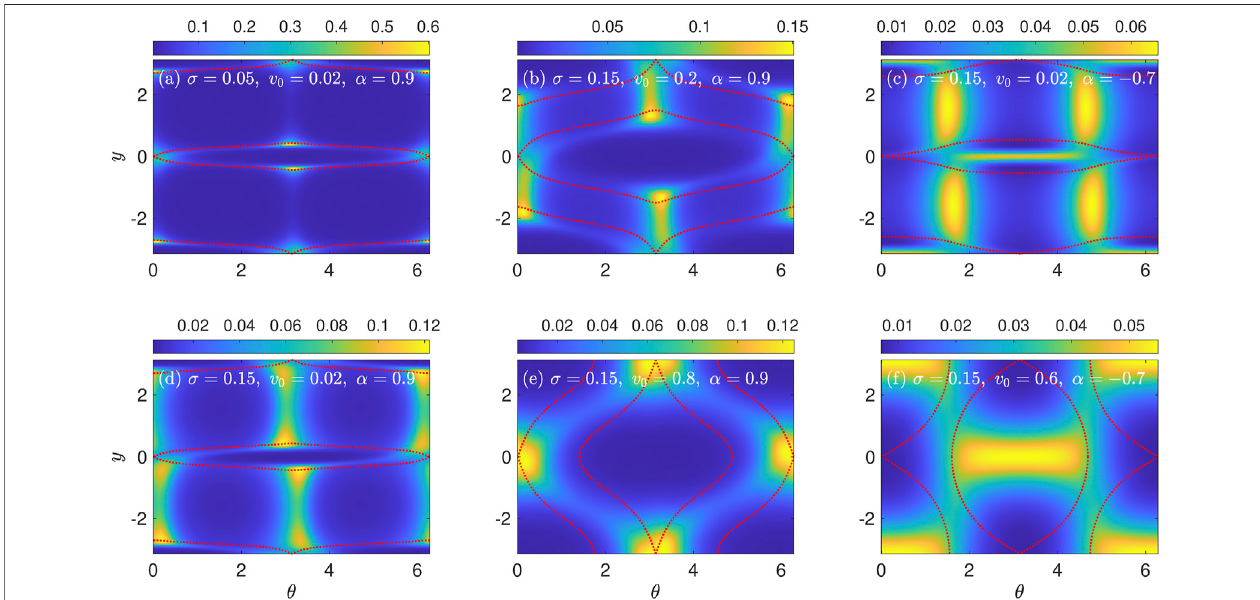
FIGURE 4 | Steady-state probability densities P ( y , θ ) for various combinations of σ , v 0 , and α indicated on each panel. Red dotted curves are the separatrices emanating from the saddles ( y , θ ) (cid:1) (0, 0) and ( y , θ ) (cid:1) ( ± π , π ). Panels (A – D) are for parameters before the bifurcation from rotational to cross-stream drift, and panels (E) and (F) are after this